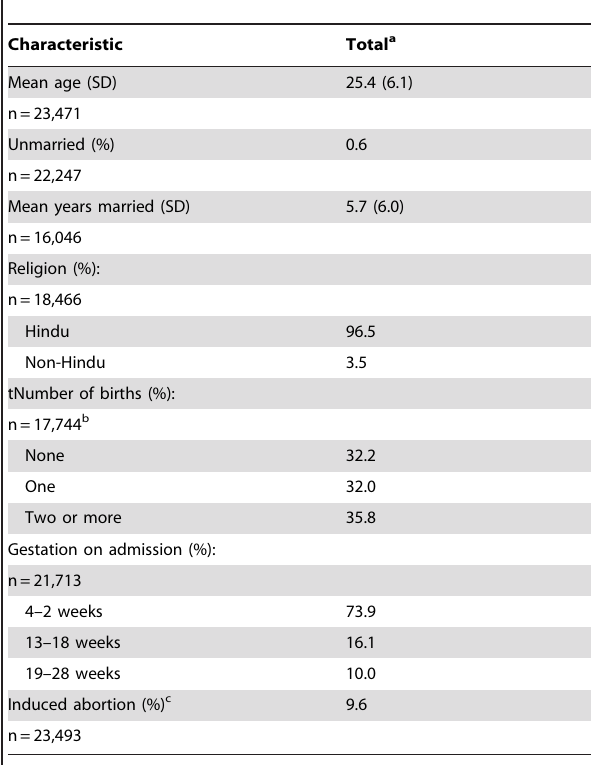
Table 1. Characteristics of patients abstracted from medical charts for all abortion complication cases, 2001–2010,